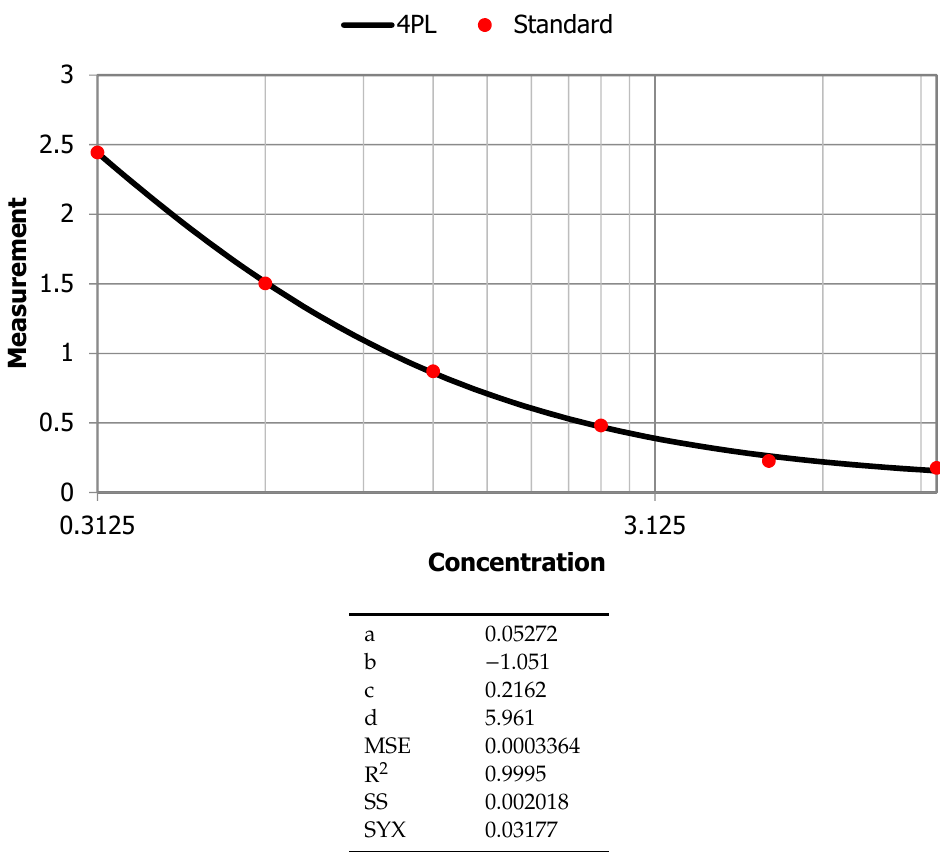
Figure A2. Anti-THSD7A standard curve.